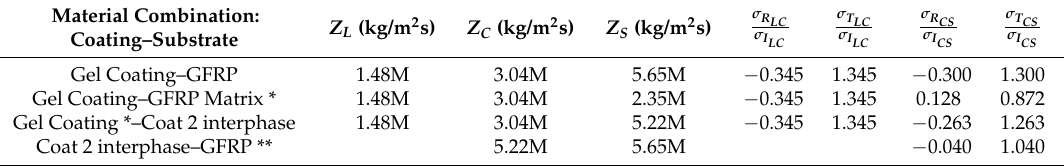
Table 3. Impedance properties of gel coating candidate materials. Reflected and transmitted waves as